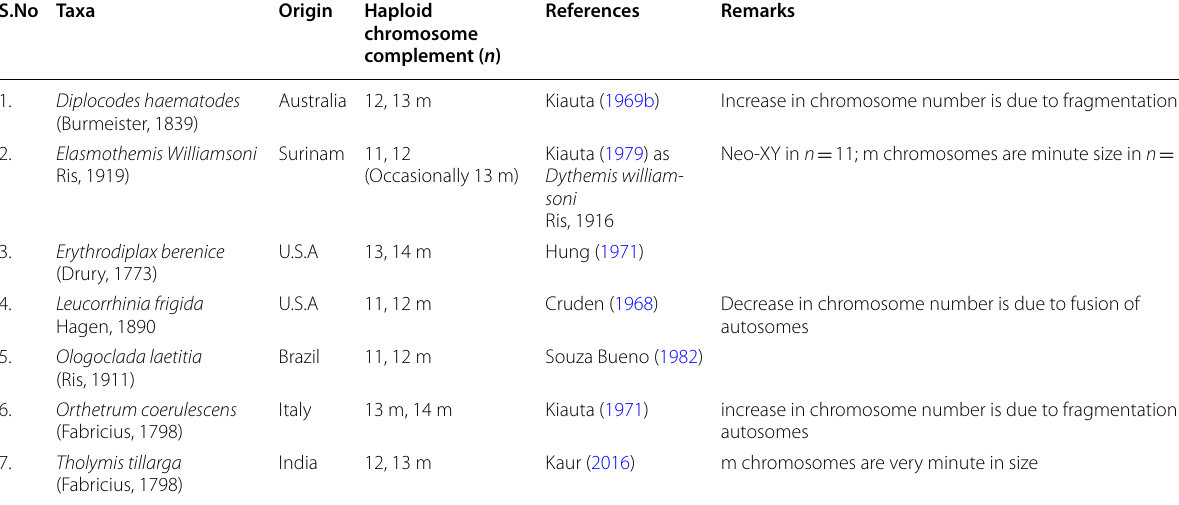
Table 3 Two chromosome complement (with/without m chromosomes) in the same speciemen of